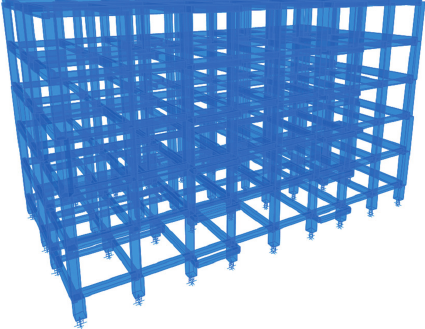
Figure 5: Finite element model of the Table 1: Parameters of the isolation bearings.